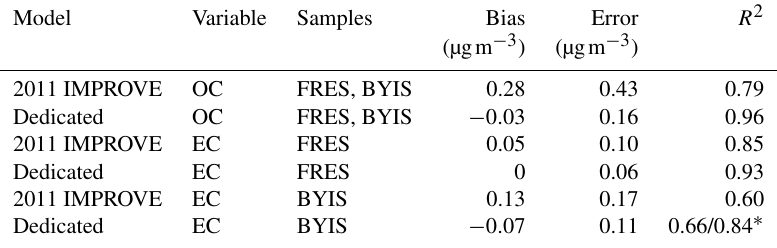
Table 3. Figures of merit for selected FRES (Fresno, CA) and BYIS (Baengnyeong Island, S. Korea) samples using base case 2011 IMPROVE calibration and a dedicated model built only using samples from FRES and